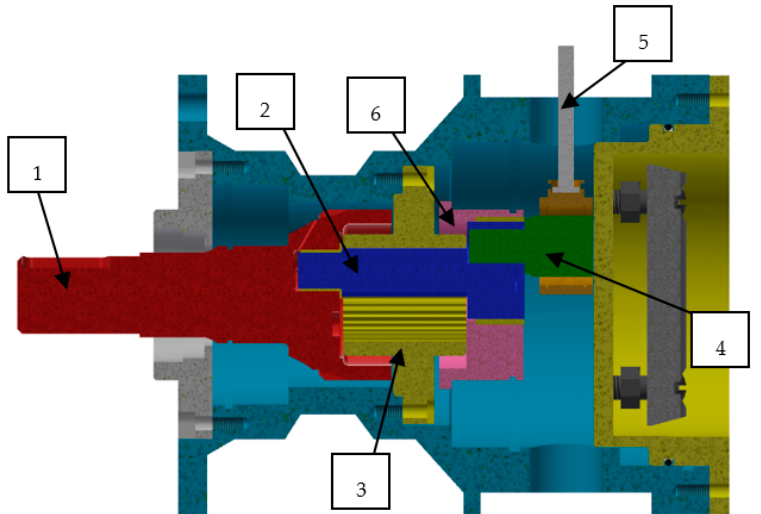
Figure 6. Cross-section of model of a high-pressure hypocycloid drive pump with the assumed simplifications: 1—main shaft, 2—intermediate shaft, 3—gearing with internal meshing, 4—mandrel, simplifications: 1 — main shaft, 2 — intermediate shaft, 3 — gearing with internal meshing, 4 — mandrel, 5 — piston (plunger), 6 — intermediate shaft support. 5—piston (plunger), 6—intermediate shaft